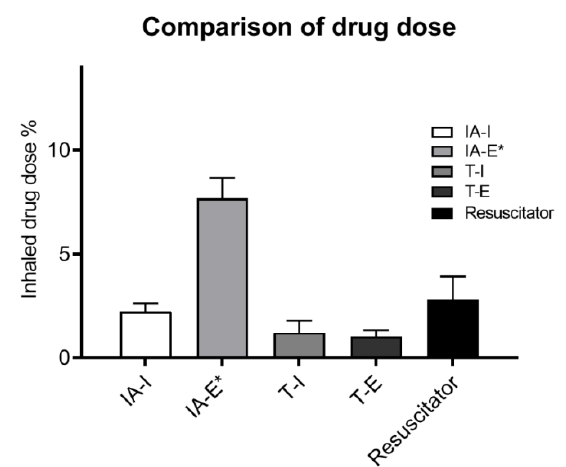
Figure 4. Comparison of the drug dose (%) collected distal to the endotracheal tube using different connections, actuation sequence, and methods of ventilation, * Significantly greater inhaled dose than other connections according to an analysis of variance ( p < 0.001) and greater dose during expiration than inspiration with the in-line adapter. Abbreviations: IA-I: in-line adapter at inspiration; IA-E: in- line adapter at expiration; T-I: T-adapter at inspiration; T-E: T-adapter at expiration .